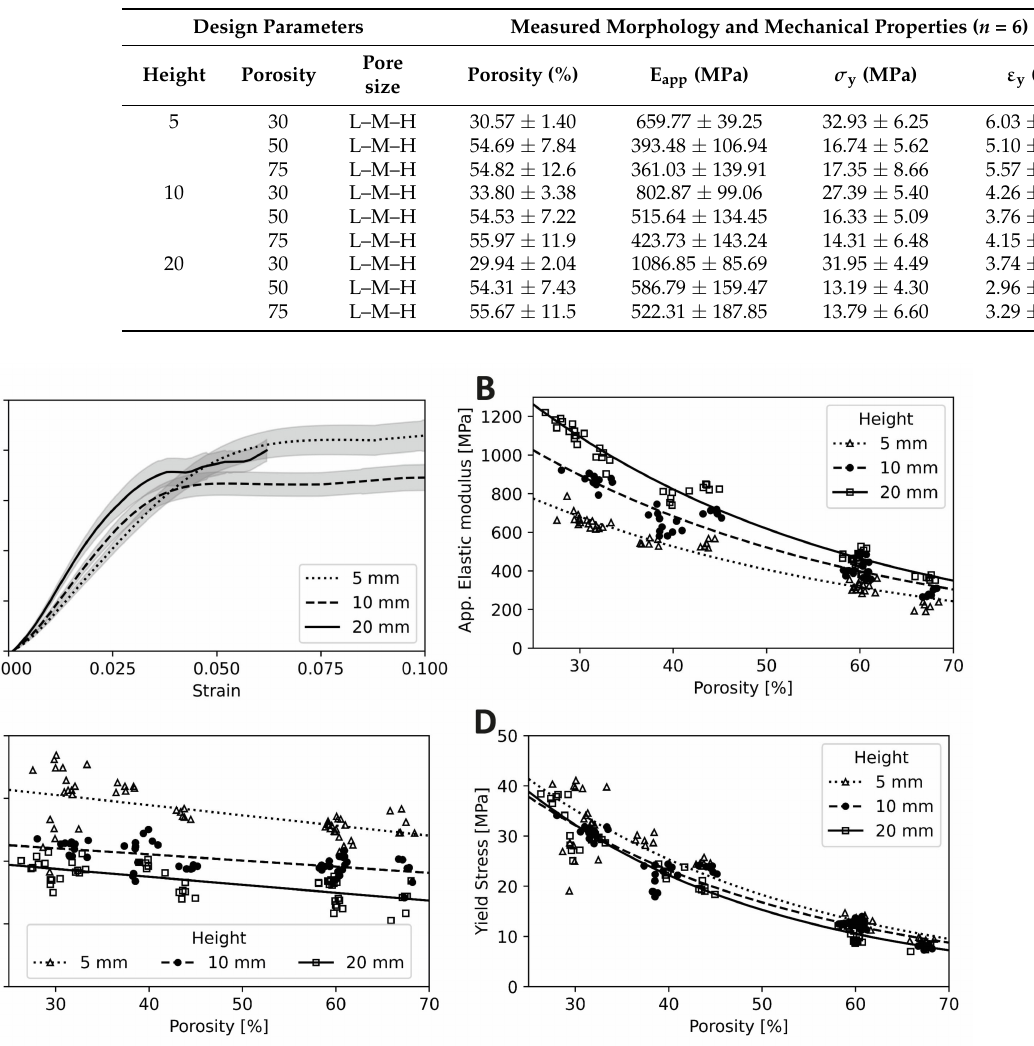
Figure 4. Mechanical properties of the scaffold test specimens: ( A ) Stress–strain curves showing the average and standard error for all the samples grouped by height. ( B ) Elastic modulus versus porosity for three specimen heights. ( C ) Yield strain versus porosity for three specimen heights. ( D ) Yield stress versus porosity for three specimen heights. Grey, shaded bands in ( A ) represent the standard